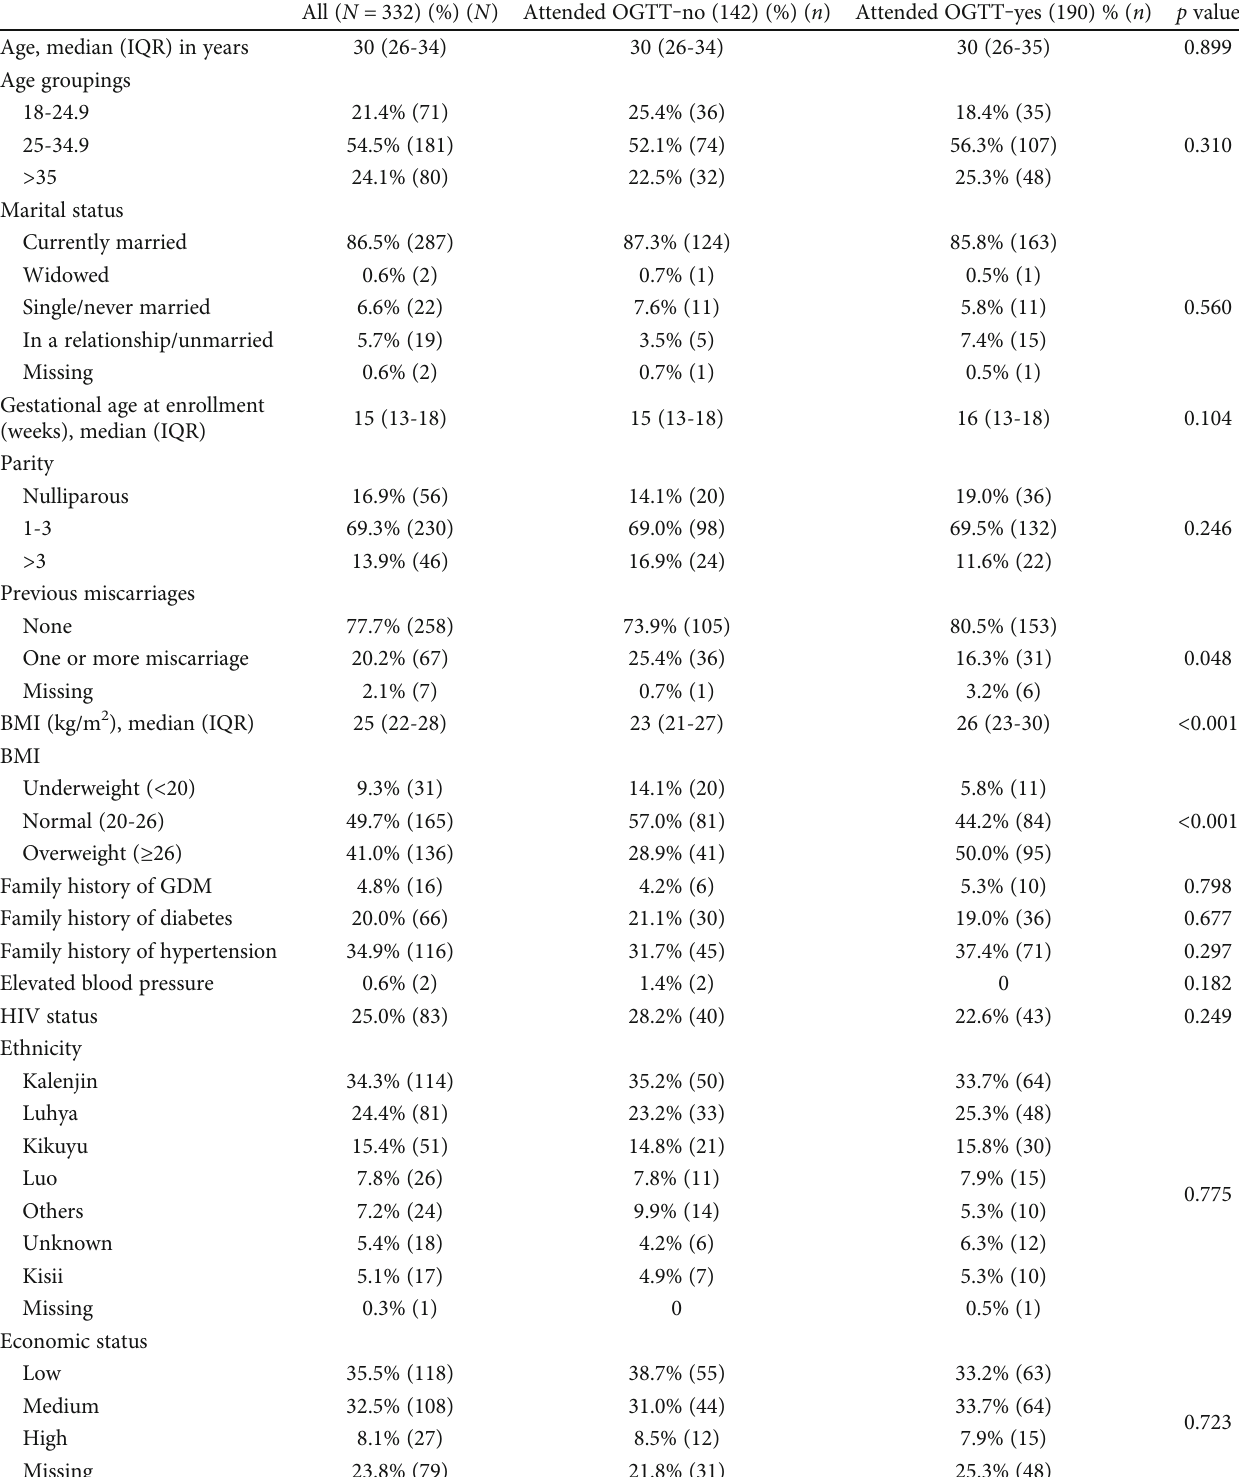
Table 2: Baseline characteristics of participants who completed and did not complete the oral glucose tolerance test between 24 and 32